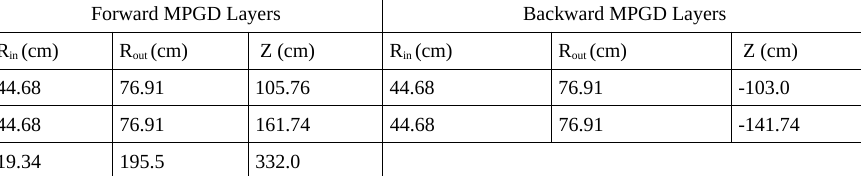
Table 5. The geometric parameters of Forward and Backward MPGD Layers